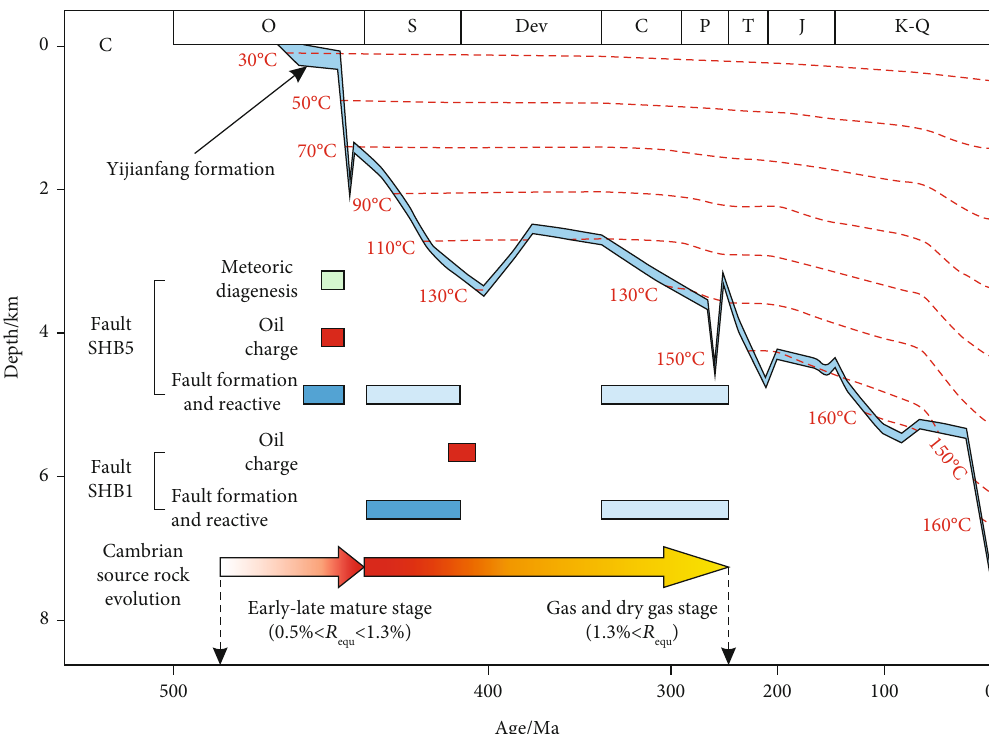
Figure 9: The model of oil charge history in the Shunbei No. 5 and No. 1 fault zones. The 1-D burial-thermal history of well SHB1-3 is from Wang et al. [27], and the Cambrian rock evolution is from Qiu et al.